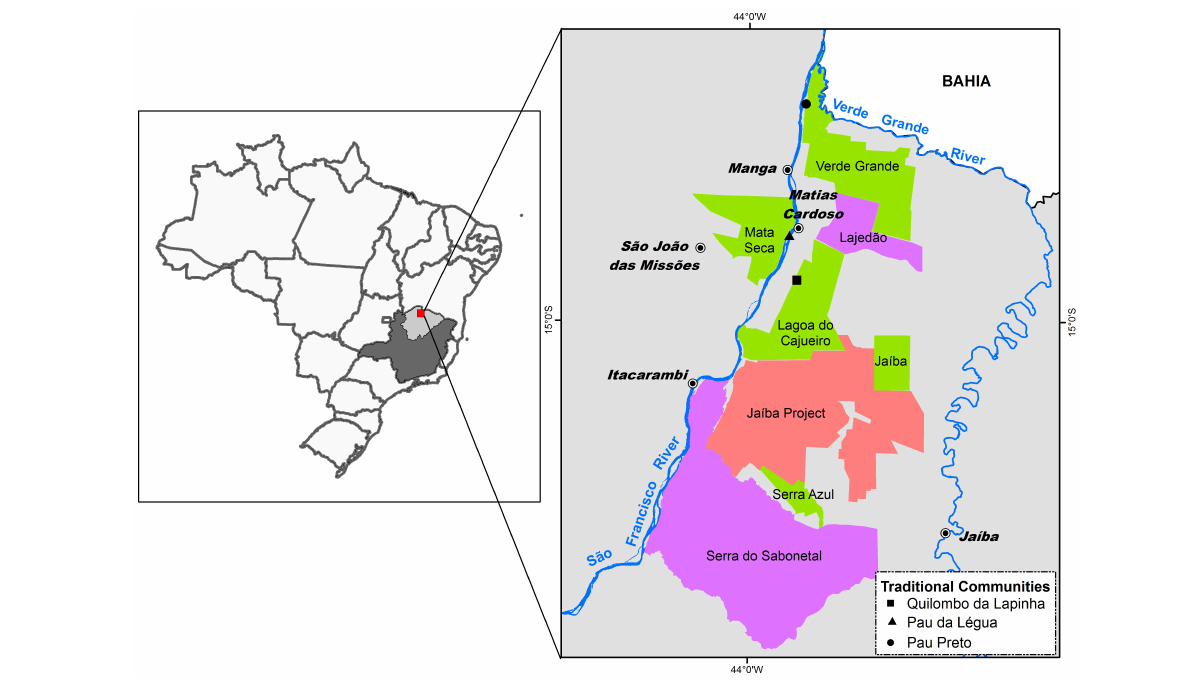
Fig. 1 . Location of the study region in the north of the Minas Gerais state, Brazil, with the protected areas (PAs) created as environmental compensation for the Jaíba Project and the affected traditional communities. The PAs of restricted use are shown in green, and PAs of sustainable use are shown in purple. The traditional community of Quilombo da Lapinha is inside the Lagoa do Cajueiro Park; Pau de Légua is inside the Mata Seca Park; and Pau Preto is inside the Verde Grande Park. The main cities of this region are also